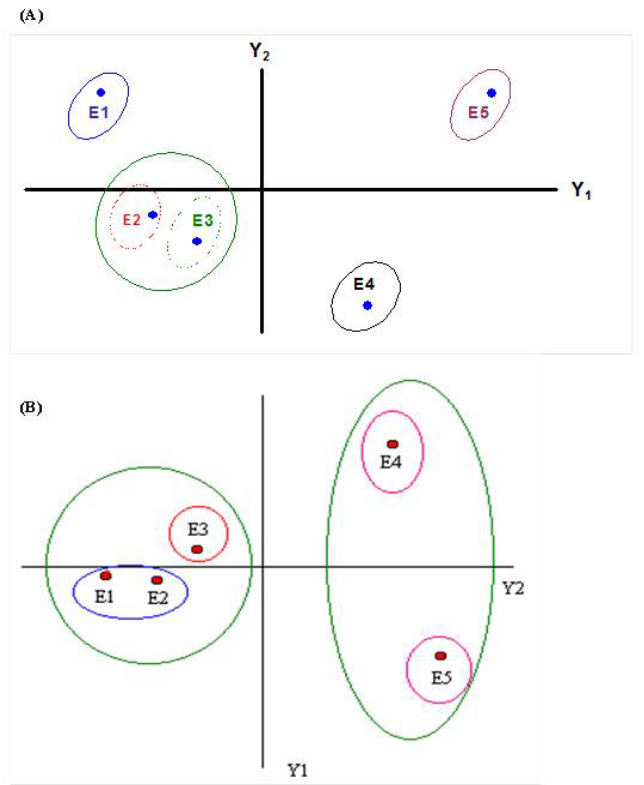
Figure 4. Dispersion graph for the five development stages of Eucalyptus grandis leaves using the two principal components (Y1 and Y2) for all the 13 quantitative anatomical descriptors of the midrib and internervural region. Dispersion graph of 6-month-old ( A ) and 20-month-old ( B ) plants. Table 4. Correlation coefficients between 13 anatomical characteristics of the midrib (Mi) and intern- erval region (IR) for the five development stages of Eucalyptus grandis of 6- and 20-month-old plants and their two main components (Y1 and